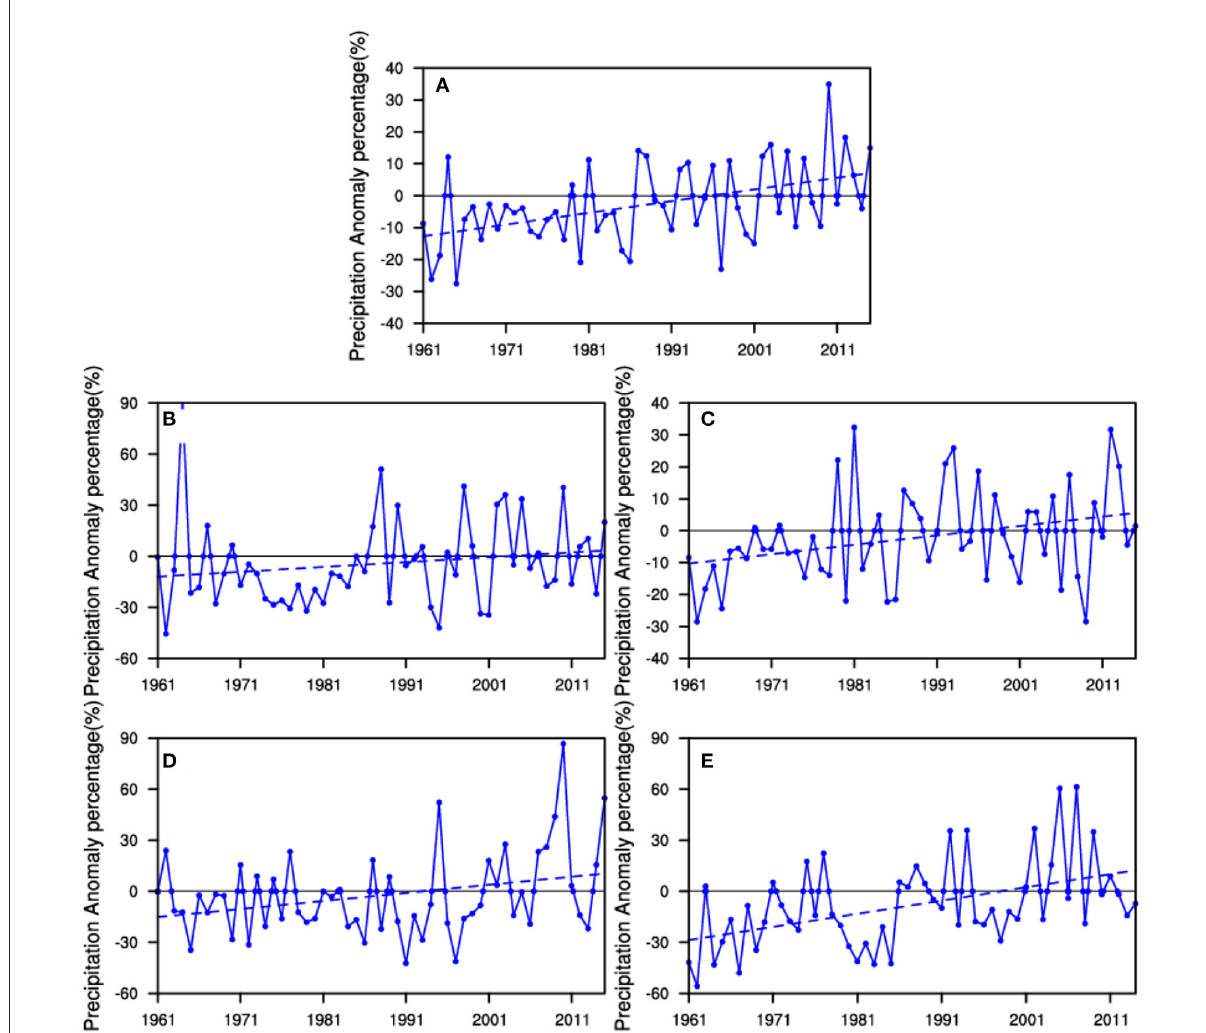
FIGURE2 Variation of precipitation anomaly percentages over Northwest China [dashed lines denote linear trends; (A) annual, (B) spring, (C) summer, (D) autumn, (E) winter; unit: %] (Wu et al.,